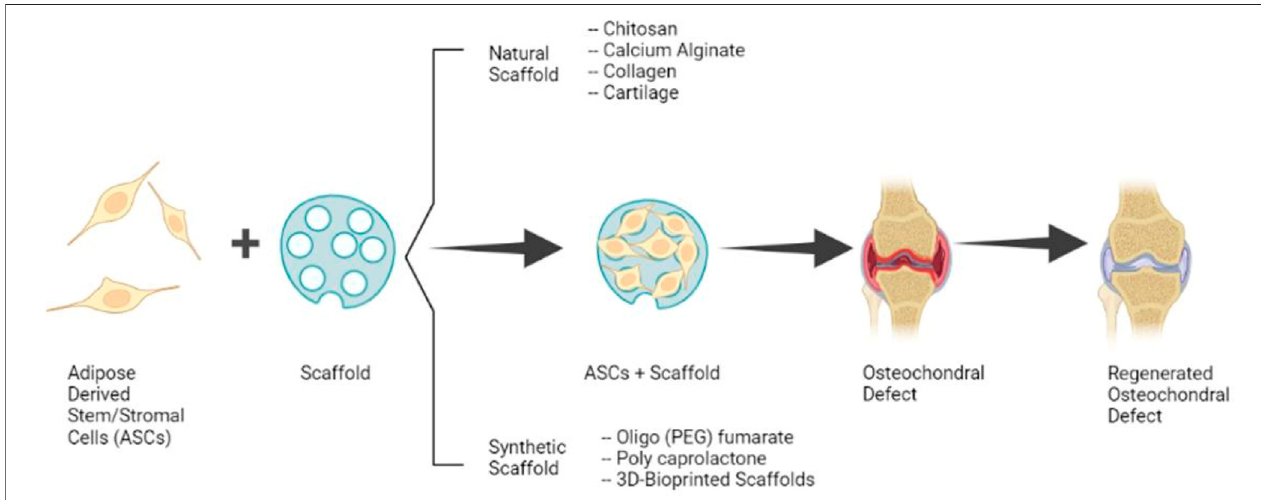
FIGURE 1 | Clinical application of ASCs and Scaffolds for the Regeneration of OC Defects. (Image created with Biorender.com).